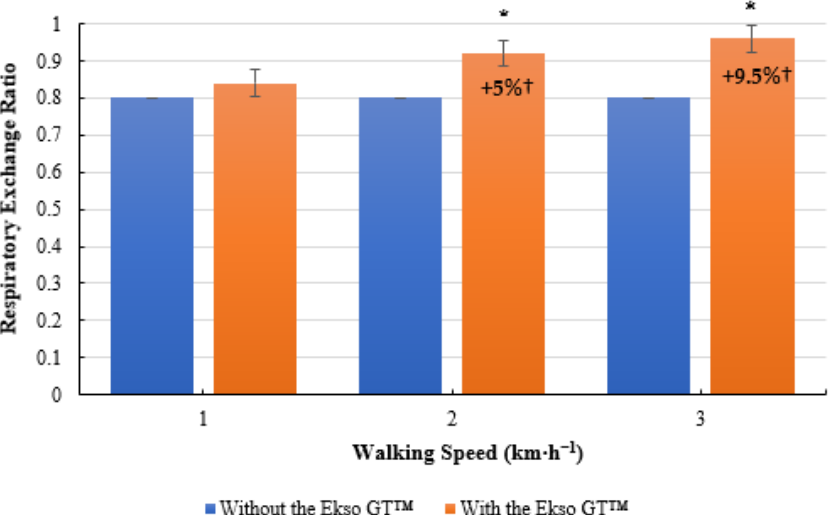
Figure 4. Mean respiratory exchange ratio (RER) results during treadmill walking with and without Ekso GT™. * Significantly greater ( p ≤ 0.05) when walking with Ekso GT™ versus walking without Ekso GT™. † Mean percentage RER increase at each walking phase both with and without Ekso GT™.